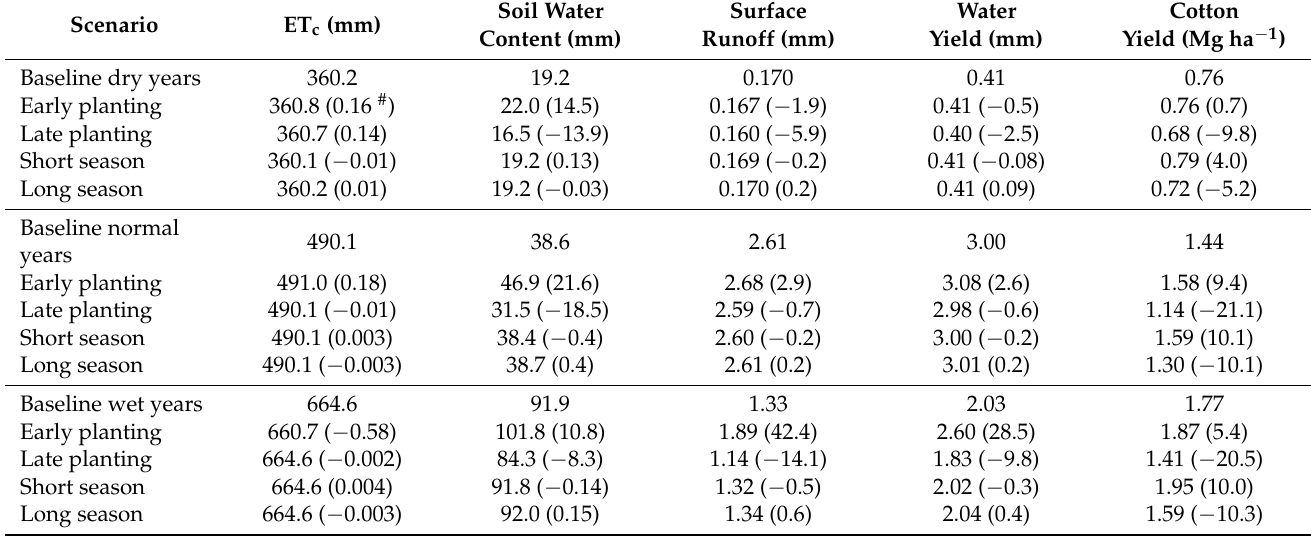
Table 5. Comparison of the average annual water balance parameters and cotton yield under three hydroclimatic regimes using various planting dates and maturity cultivars in the dryland cotton HRUs in the Double Mountain Fork Brazos